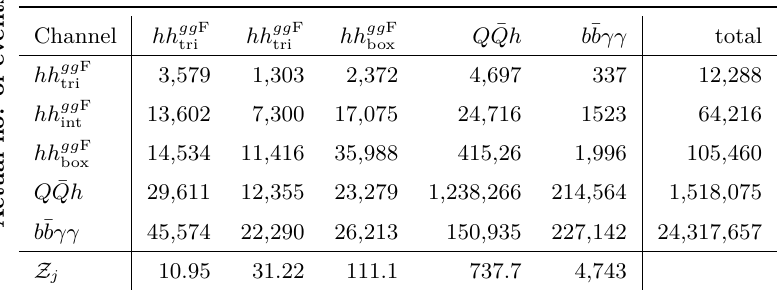
Table 4 . Trained BDT classification (confusion matrix) of the five channels used to extract constraints on C (or κ ) at FCC-hh with 30 ab − 1 luminosity, assuming SM signal injection. The φ λ right-most column gives the total number of events expected in each channel in the SM and the bottom-most row gives the signal